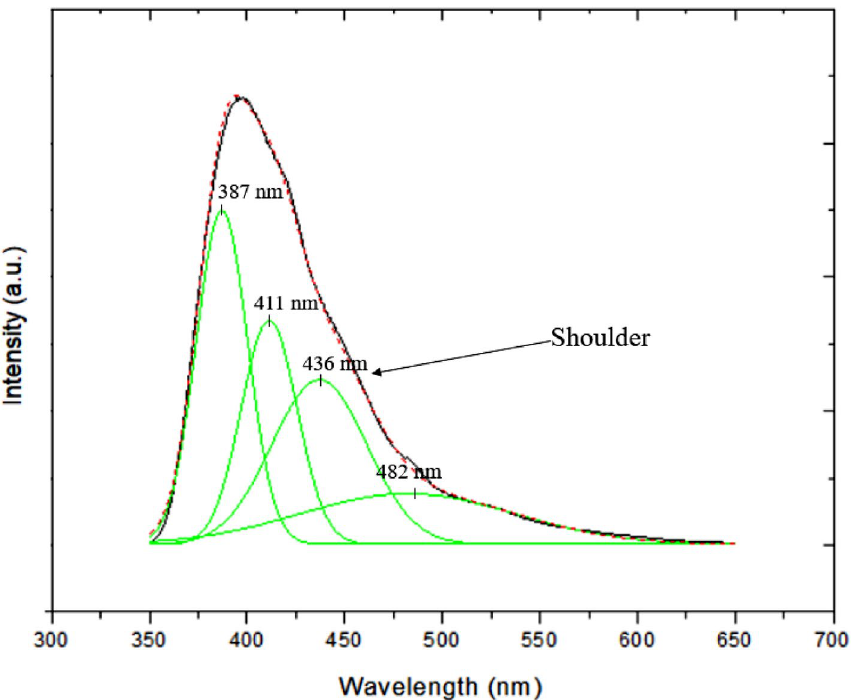
Figure 8. The room-temperature PL spectrum of as-synthesized SiC/SiO 2 nanowires with the excitation wavelength of 325 nm. The red line is the sum of all decomposition peaks, which fits original experiment data very